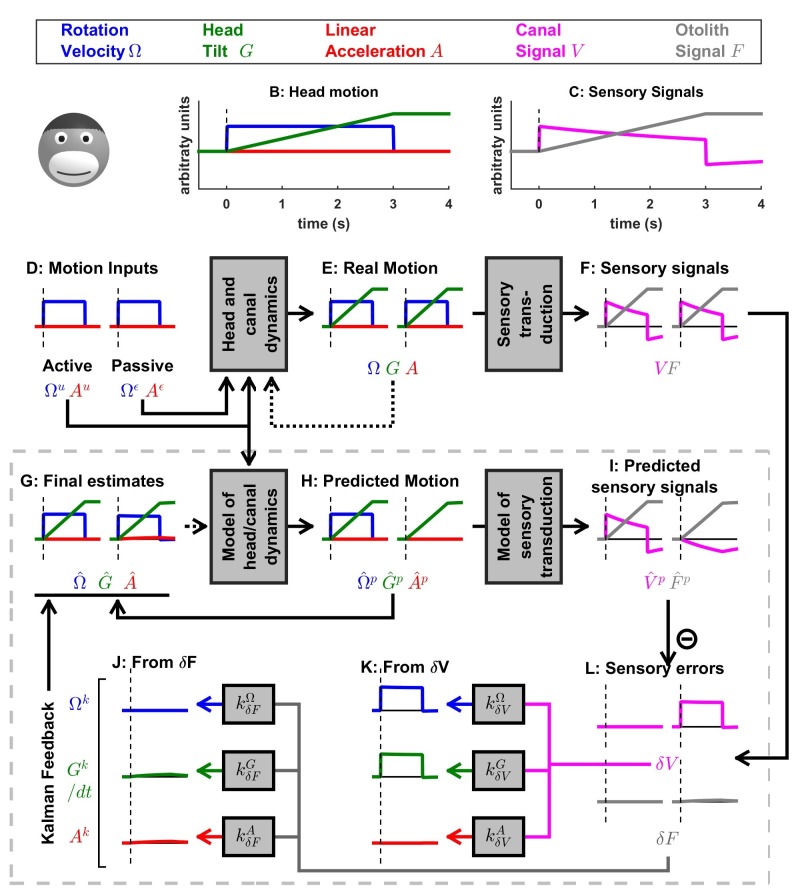
Simulation of medium duration (2 s) head tilt movement.Panels as in Figure 5; the canal dynamics state variable, C, is shown in cyan. Although canal responses exhibit significant dynamics (magenta in panel C), rotation perception remains accurate (panel G, blue traces) during both active and passive tilts (as in Figure 4). The final estimate of tilt (panel G, green traces) is also accurate during active and passive tilts. As a consequence, the otolith error (panel L, gray traces) and the corresponding Kalman feedback (J) are negligible. Note that the feedback to Gk and Ck is scaled by a factor 1/δt (because of the integration; see Supplementary methods, ‘Kalman feedback gains’).